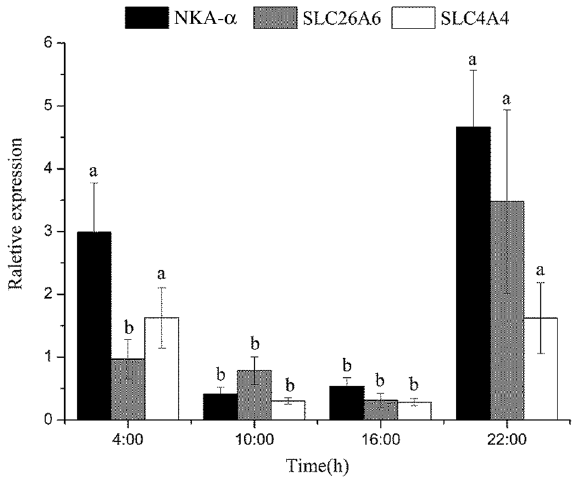
Figure 3. NKA-α, SLC26A6, SLC4A4 mRNA expression levels in the mid-intestine of Gymnocypris przewalskii at different time points (4:00, 10:00, 16:00 and 22:00) exposed to saline-alkaline lake water with a salinity of 17.